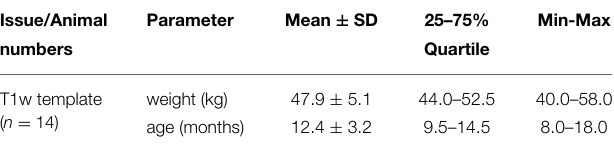
TABLE 1 | Demographic data of subjects used for T1w template